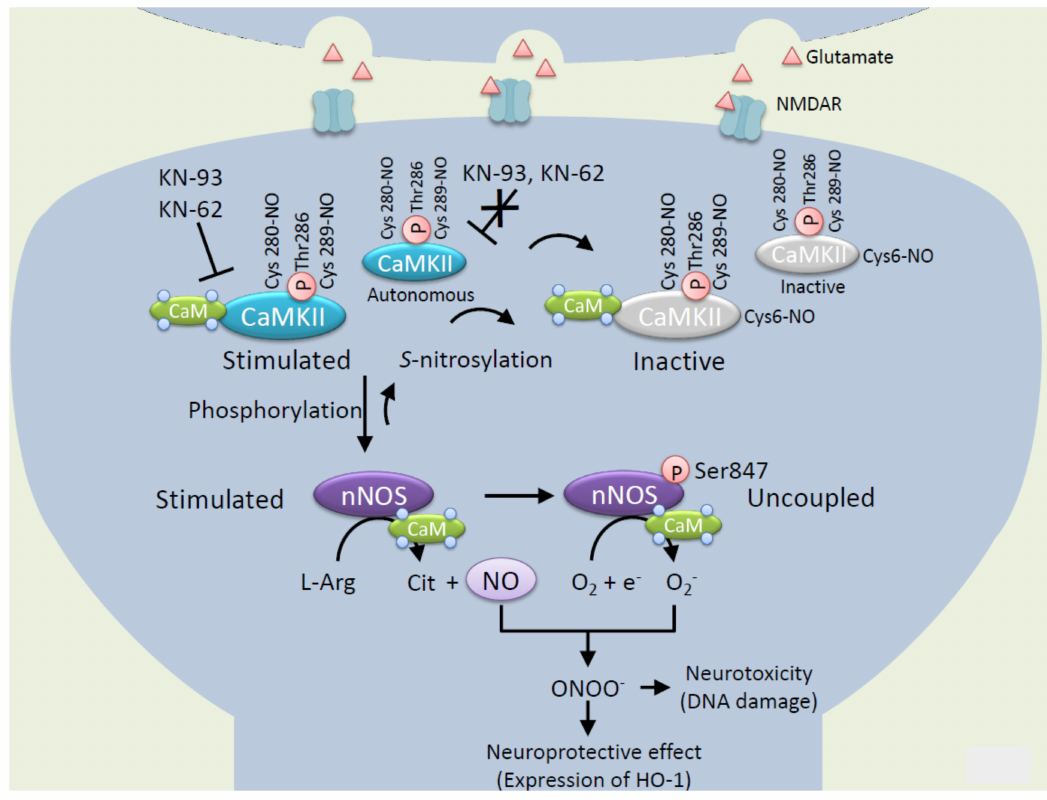
Figure 3. Mutual regulation of nNOS and CaMKII in the nerve systems. Both CaMKII and nNOS are activated by CaM binding (Stimulated). CaMKII is either autophosphorylated at Thr286 or S -nitrosylated at Cys280 / Cys289 and earns Ca 2 + independent autonomous activity. KN-93 and KN-62 generally used as CaMKII inhibitors inhibit CaM binding of CaMKII and thereby autonomous activity of CaMKII is not inhibited by KN-93 and KN-62. nNOS-derived NO inhibits CaMKII activity and both Ca 2 + dependent and Ca 2 + independent autonomous activity via S -nitrosylation at Cys6 with ATP competitive fashion [39]. On the other hand, CaMKII phosphorylates at Ser847 of nNOS which decrease NO synthesis and increase superoxide (O 2– ) synthesis. O 2– reacts with NO to form peroxynitrite which indicates neurotoxic e ff ects with oxidation of DNA [67]. Peroxynitrite also works as a signal molecule when it induces expression of cytoprotective proteins such as heme oxygenase-1 (HO-1) [28]. Ca 2 + signals orchestrate NO and superoxide and phosphorylation by interaction between CaMKII and nNOS in the central nervous system. This figure is an image of the postsynaptic hippocampal neuron where the mutual regulation of nNOS and CaMKII mainly